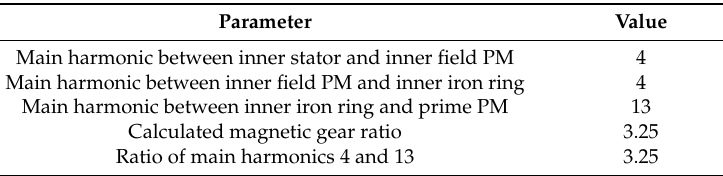
Table 4. Outer air-gap flux density performance of the magnetic gear.